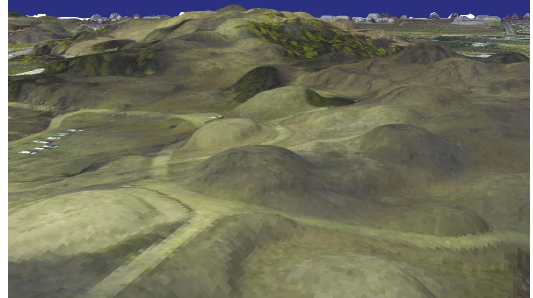
Fig15. Animation by Land-Viewer (OrthophotoImage+ Lidar)